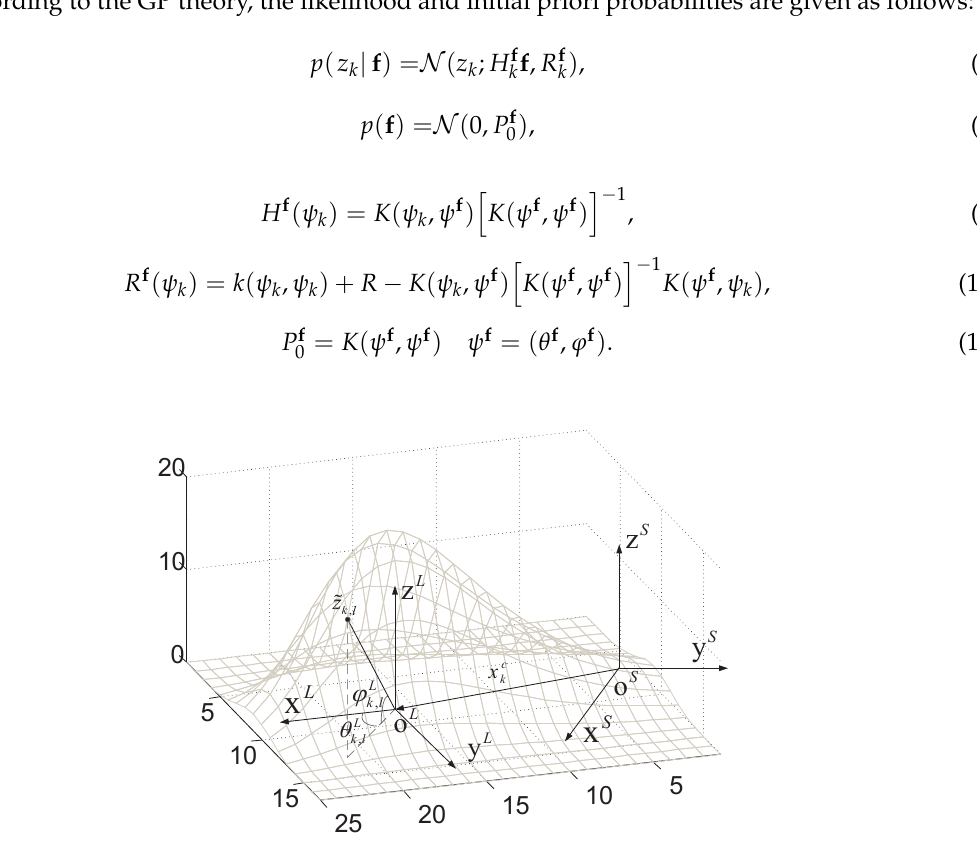
Figure 1. Sketch of the target surface described by a solid radial